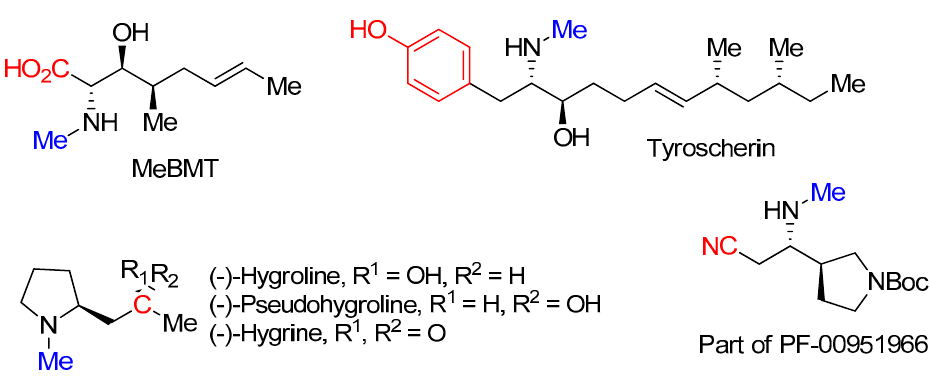
Figure 1. Biologically important molecules synthesized through N -methylative aziridine ring-opening reactions. Methyl groups (Me) shown in blue; nucleophiles shown in red.